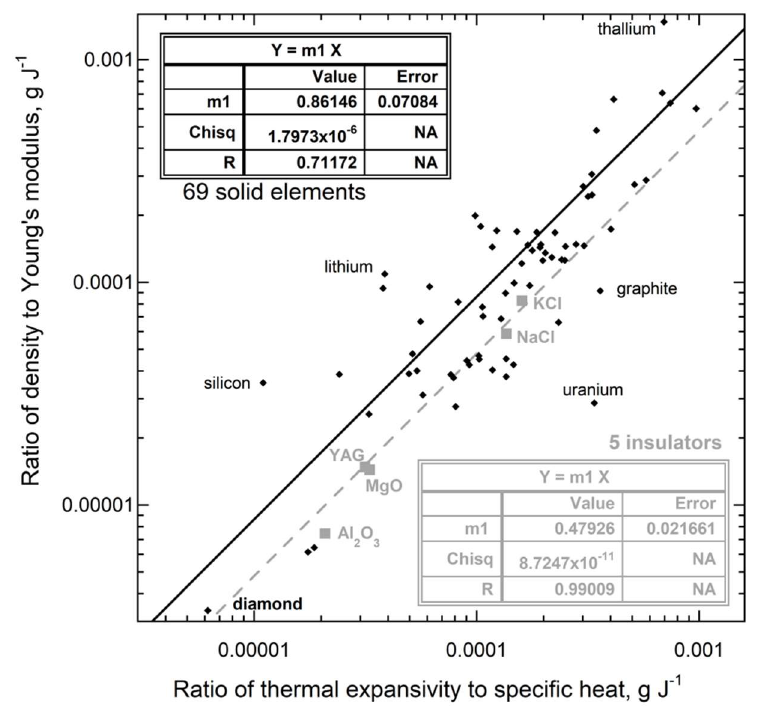
Figure 13. Evaluation of Equation (43). Data on α , ρ , and c P from [37,39,80,81]. Young’s modulus data from [41,82]. The five insulators are examined below: see Section 3.3.2 for details and sources.